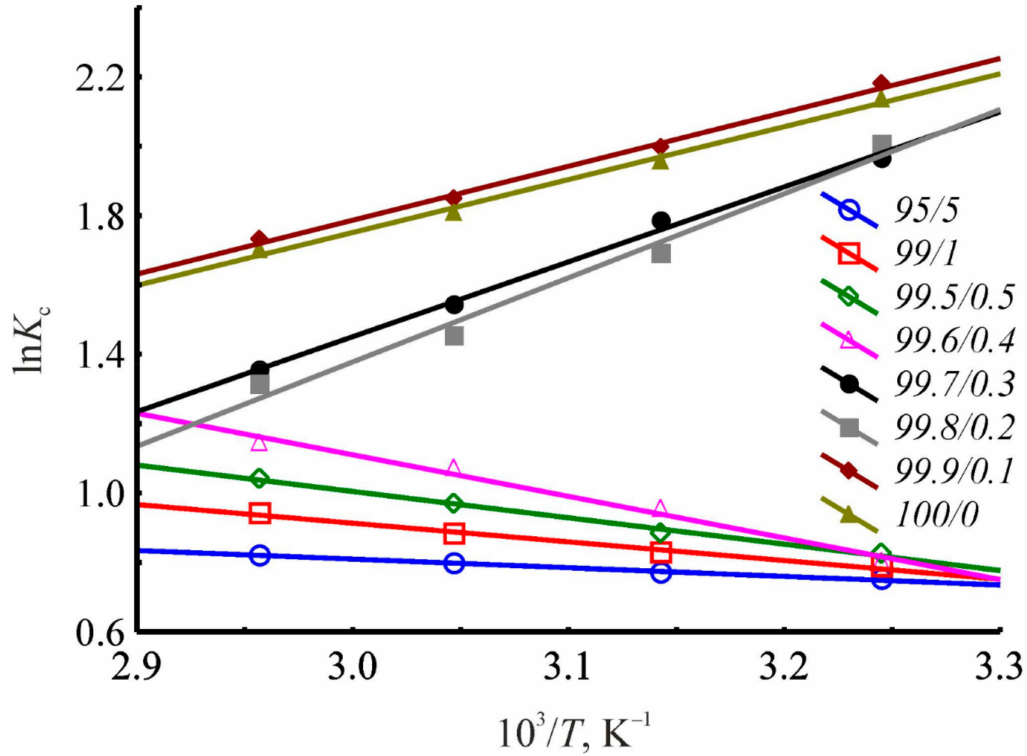
Figure 11. Dependences of the logarithm of the benzene distribution constant on the reciprocal temperature during adsorption onto the HKUST-1@BPS ( 3 )